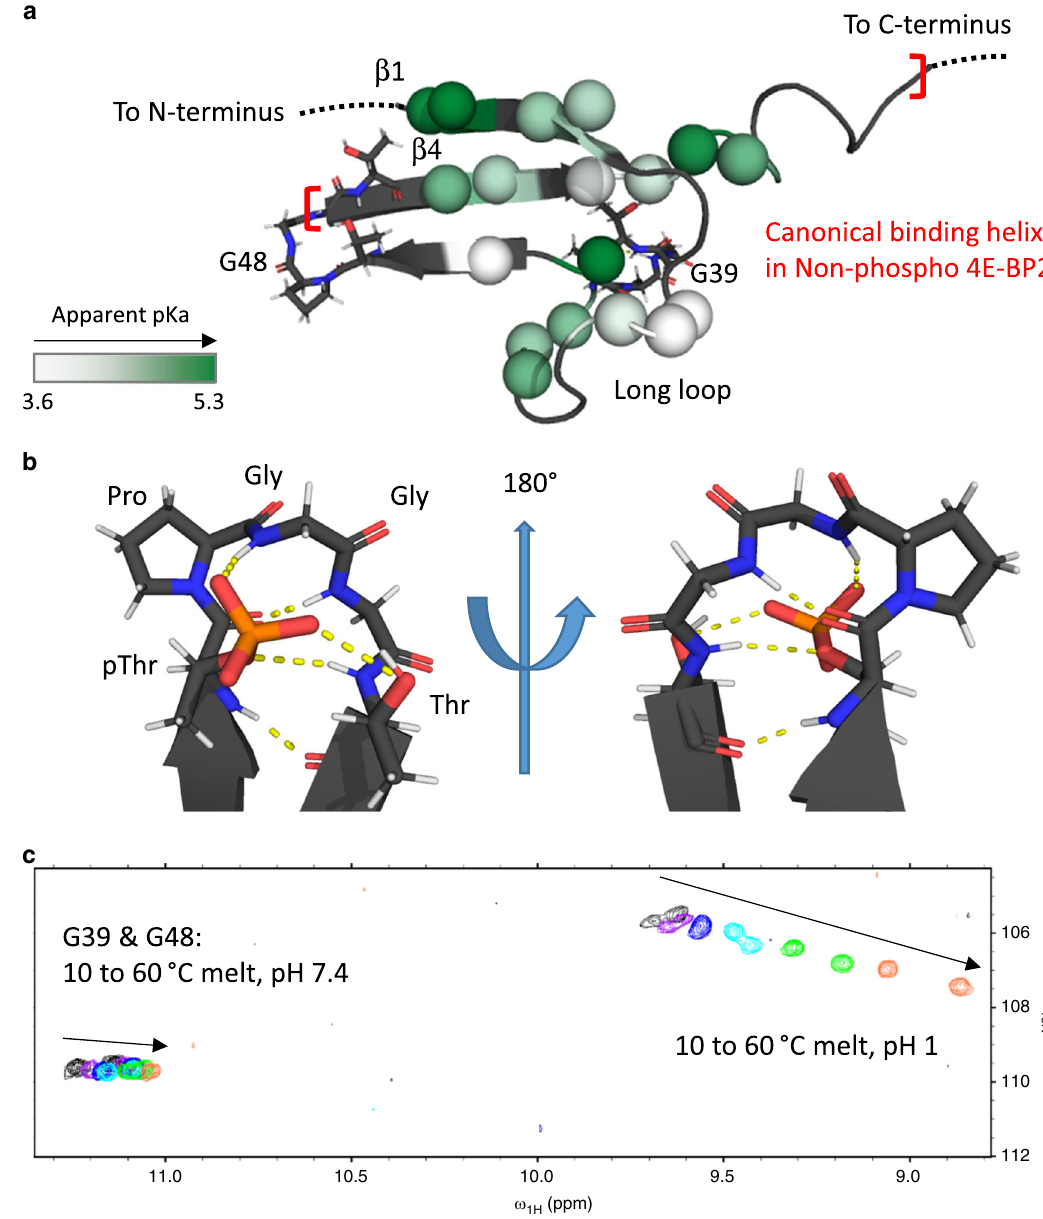
Fig. 2 Non-cooperative folding of fi ve-phospho 4E-BP2 folded domain. a Apparent p K a values from acid denaturation at 20 °C mapped onto residues 18 – 62 of the 5p-4E-BP2 using a white to green gradient, not including the hairpin turns shown in stick diagrams. The location of the canonical eIF4E-binding helix found in np-4E-BP2 is indicated by red brackets, highlighting that the folded domain disrupts the binding conformation. The variation in apparent p K a during acid denaturation is consistent with non-cooperative folding of the domain. b Hairpin turn for a pTPPGT motif with hydrogen bonds (PDB code 2MX4). c Acid and thermal denaturation of hairpin glycine residues, G39 and G48. A selected section of overlaid NMR HSQC data is shown for the thermal denaturation (between 10 and 60 °C) of 5p-4E-BP2 at pH 7.4 and pH 1.0. The hairpin residues have a different unfolding mechanism than the rest of the domain. Source data for Fig. 2a and b are provided as a Source Data fi